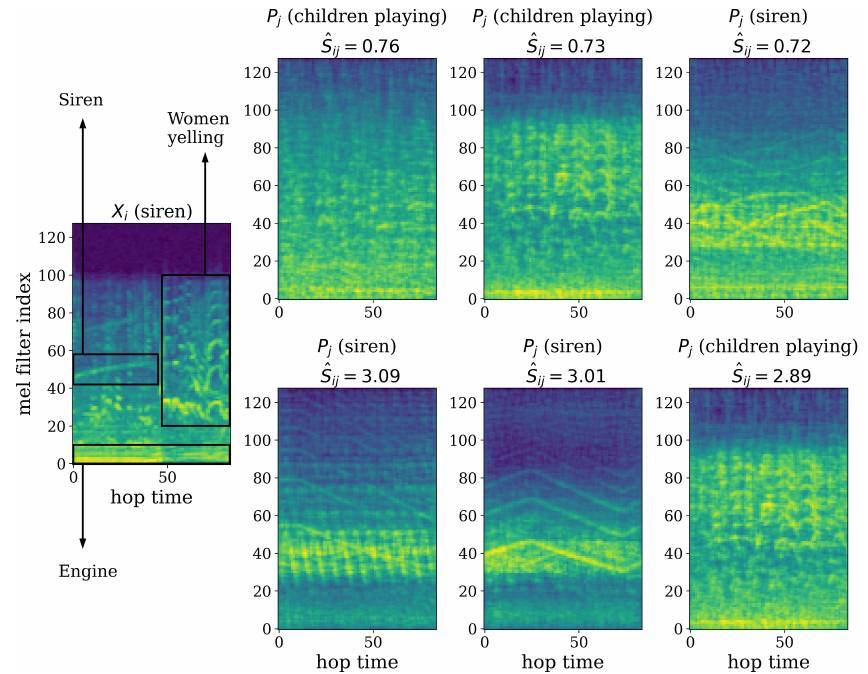
Figure 8. Example on the importance of the weighted sum layer. To the left, the mel-spectrogram, X i , of an audio slice that includes several sources: siren in the background along with a women yelling, and an engine in the foreground. Using a mean operation instead of the weighted sum, the two closest prototypes are from children playing ( top row ). However, applying the weighted sum, the two closest prototypes are from the correct class, siren ( bottom row